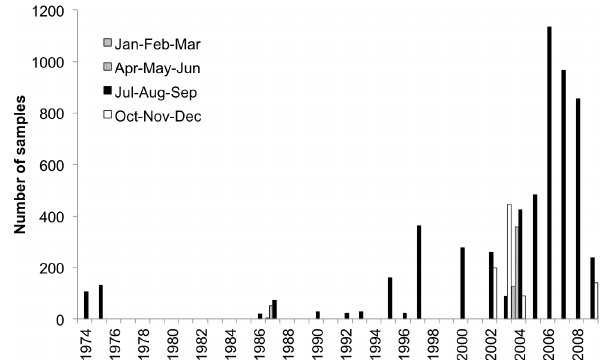
Figure 5. Timeline of the di ff erent methods used by IOS for DIC and alkalinity analyses. See Sect. 3.2 for